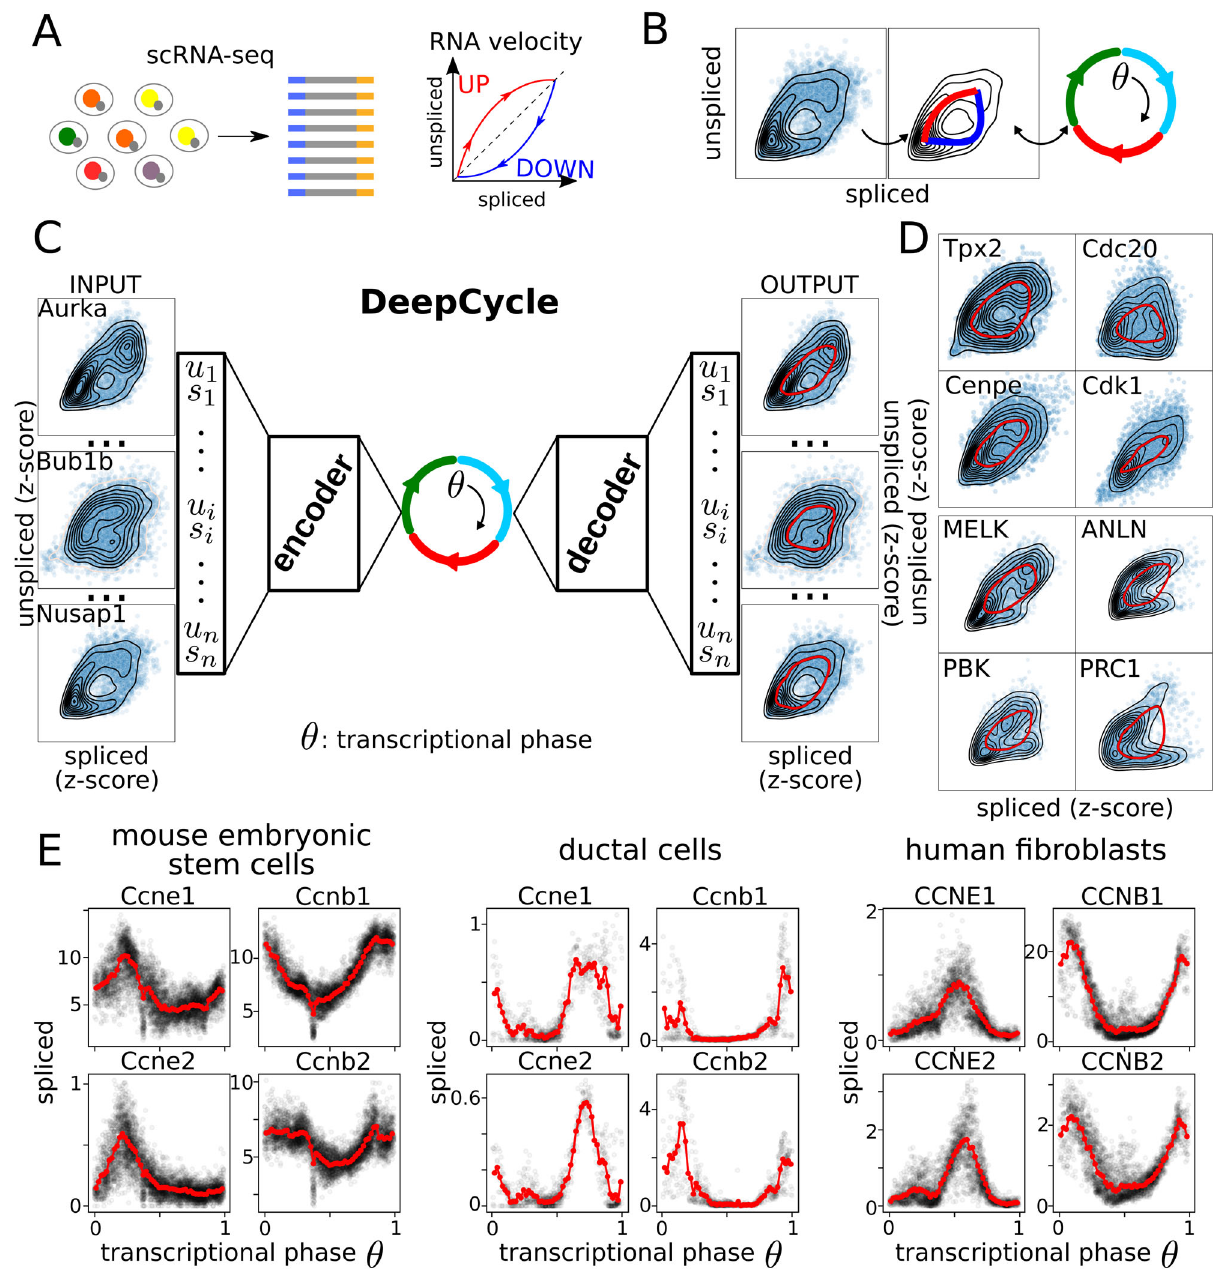
Fig. 2 Transcriptional phase inference with DeepCycle. A Single-cell RNA-seq combined with RNA velocity analysis allows the detection of transcriptional changes within a single cell. B Fully circular RNA velocity patterns can be mapped to an angle describing the transcriptional state of a gene. By generalizing this to all genes, the angle will describe the actual transcriptional state of a cell. The angle is called the transcriptional phase . C DeepCycle infers the transcriptional phase of each cell. It takes as input the spliced-unspliced reads (s i , u i ) for a set of n genes (i = 1, … ,n). By fi tting the transcriptional phase θ , it can denoise and predict the unspliced-spliced expressions for each transcriptional phase. D Examples of cycling genes and fi ts of the RNA velocity patterns (red lines) in mESCs and human fi broblasts. E Cyclin E and B levels along the transcriptional phase in the three datasets. Negative controls for non-cycling genes have been added for comparison in Supplementary Fig.